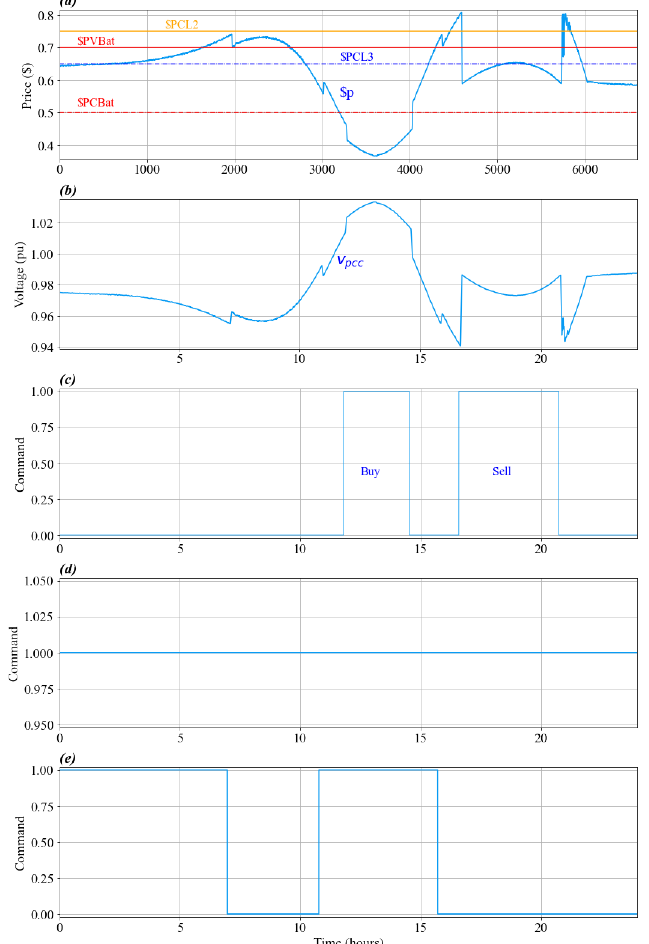
Figure 24. MG operating in connected mode with bus abundance of active power. Commands: ( a ) En- ergy price; ( b ) Bus voltage; ( c ) Battery bank command; ( d ) Load 2 command; ( e ) Load 3